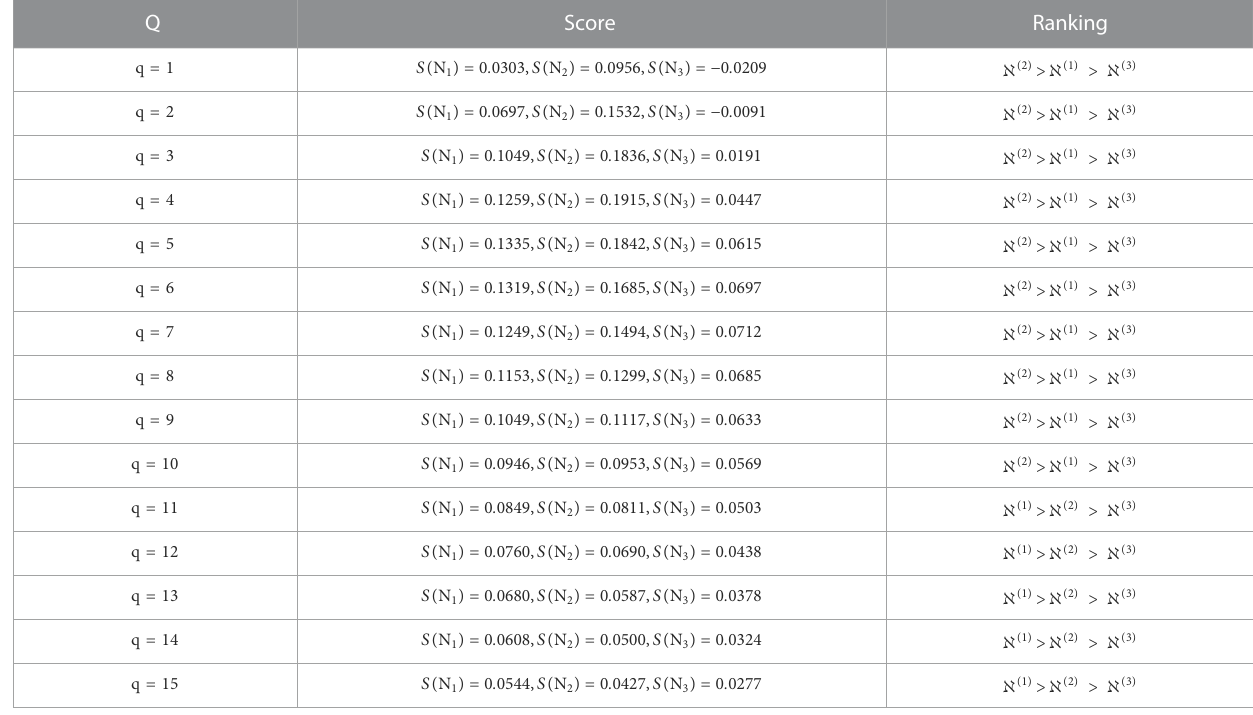
TABLE 3 Effects on decision results by variation of “ q ” under the q-ROFHSEOWA operator. Q Score Ranking